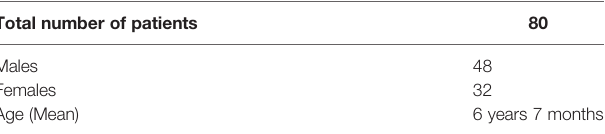
TABLE 1 | Patient demographic